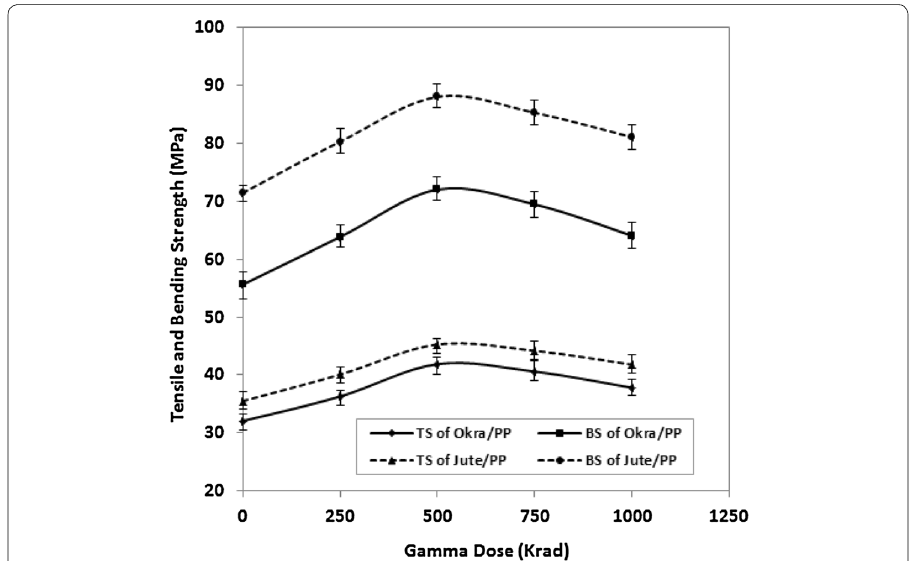
Fig. 3 Comparative tensile and bending strength of irradiated composites against radiation